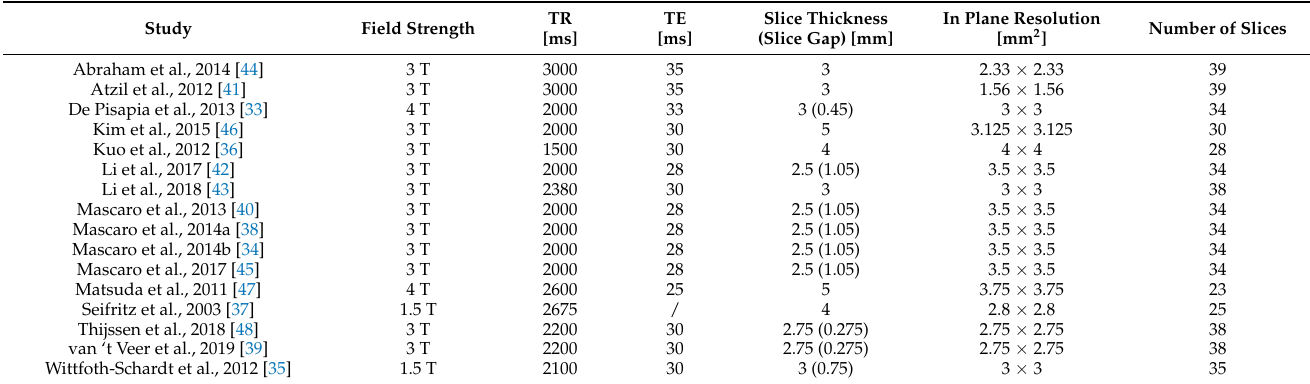
Table 3. Summary of the most common fMRI sequence